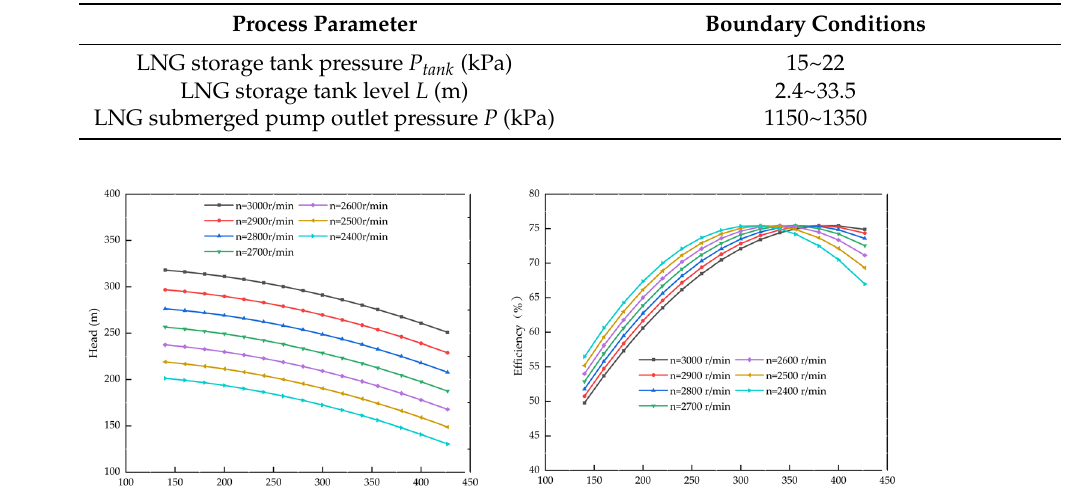
Table 1. Constraints of the LNG submerged pump system in an LNG receiving terminal.